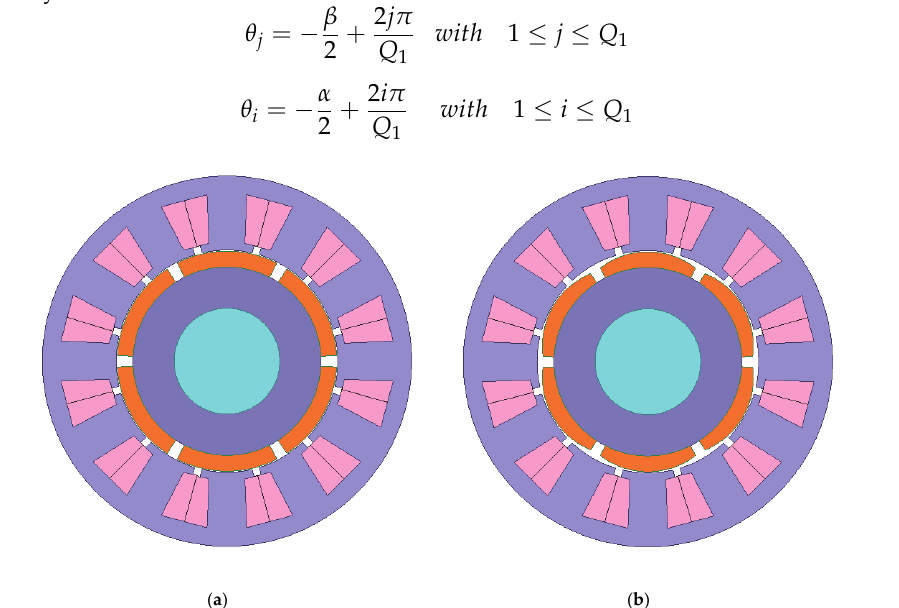
Figure 1. The geometrical representation of the investigated machines with ( a ) uniform rotor shape, ( b ) non-uniform rotor